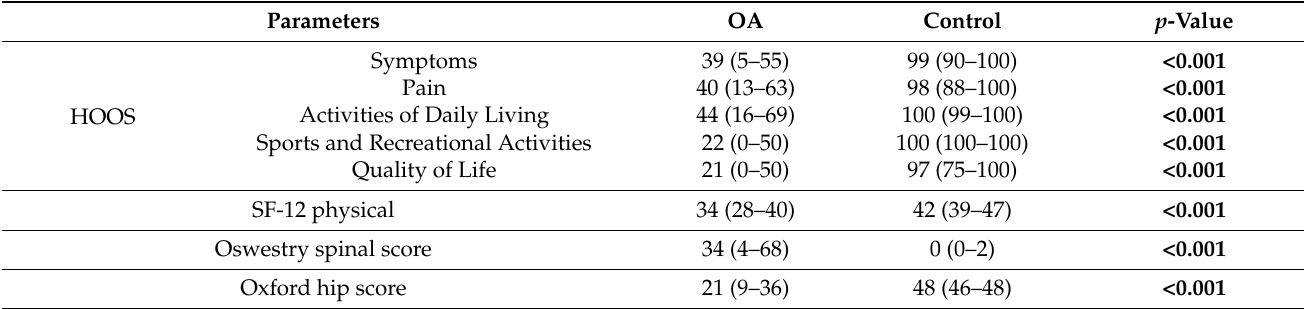
Table 2. Summary of participants’ patient-reported outcome measures, reporting mean